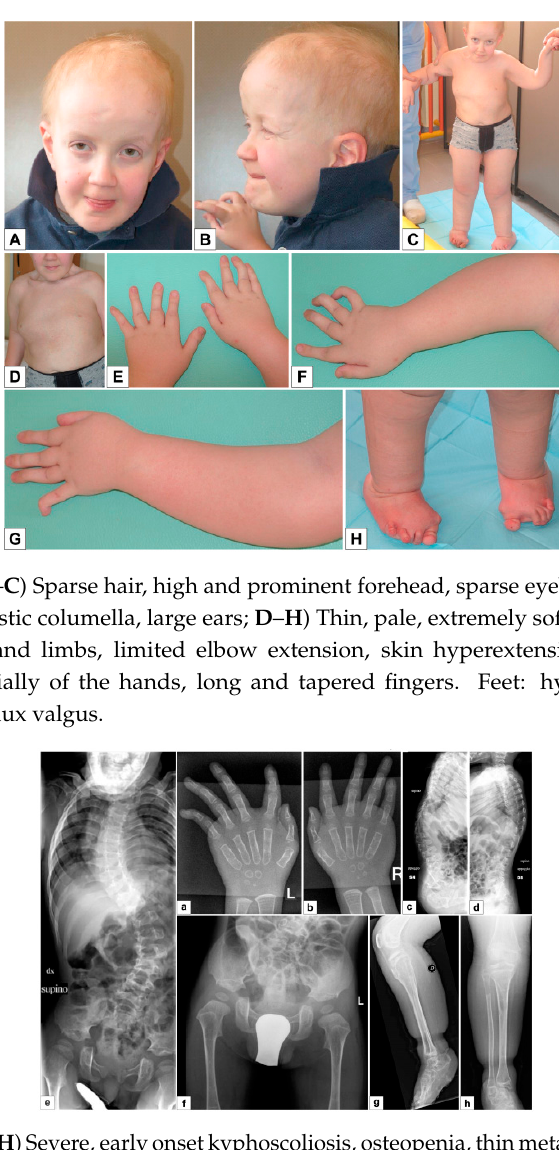
Figure 6. Patient 2 A – H ) Severe, early onset kyphoscoliosis, osteopenia, thin metacarpals and phalanges.